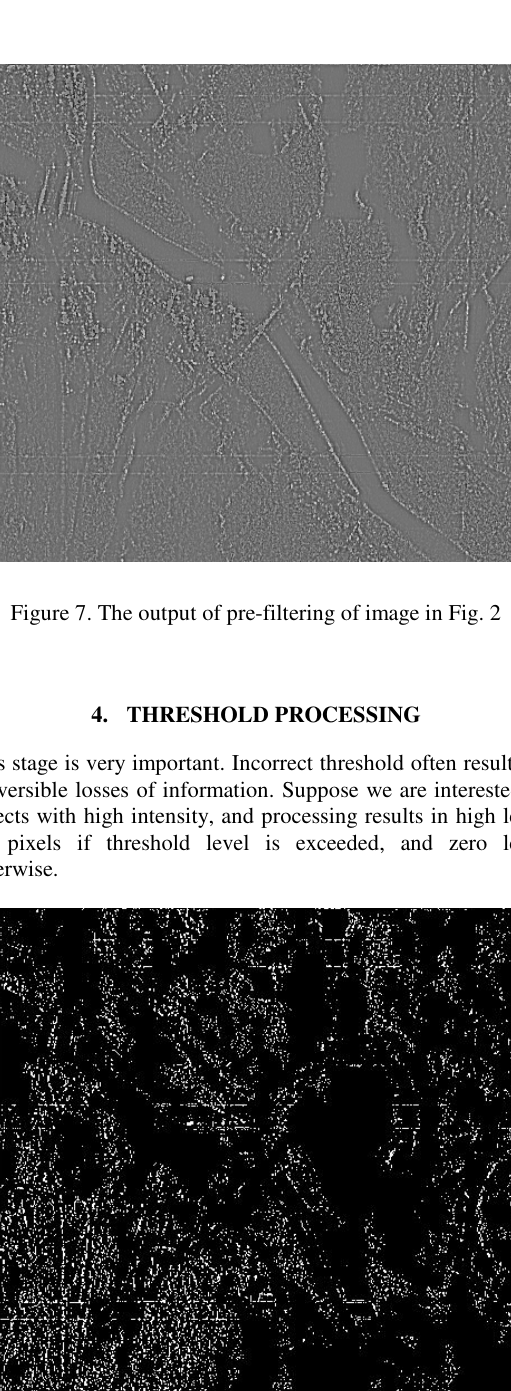
Figure 8. Binary image after low threshold level Fig. 8 - Fig.10 illustrate changes of binary images upon threshold variations from low to high levels for image shown in Fig. 7. As it may be easily observed from Fig. 8, low threshold (two pictures on top) is not appropriate because of segmentation problems: useful and noisy objects do not differ in extensions. As far as threshold level rises, differences between extensions of objects start to appear, but at very high levels (bottom pictures) we can see destroying of useful extensive objects. The best threshold level gives maximal differences in extensions between useful and noise